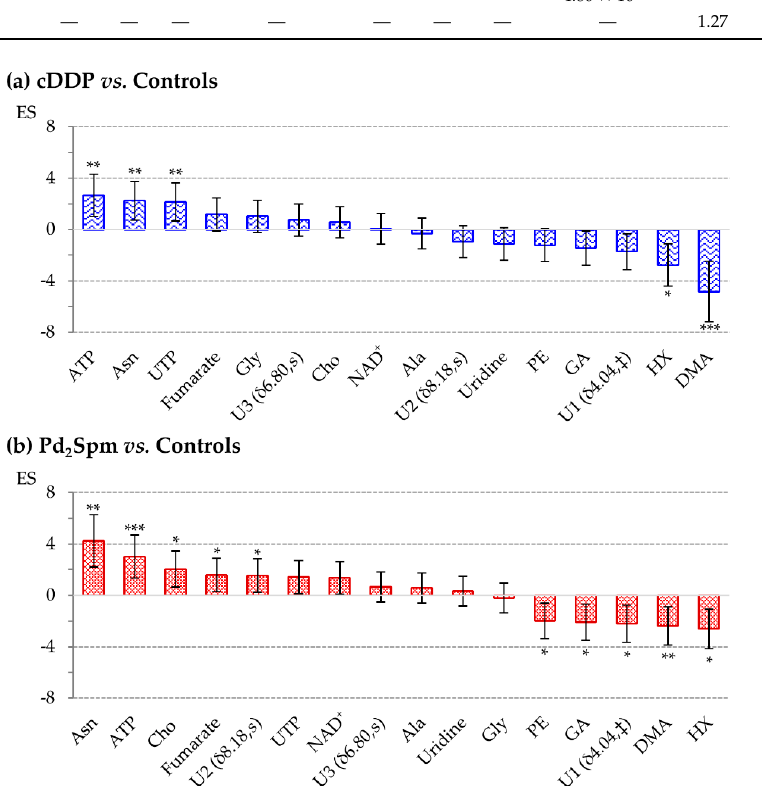
Figure 4. Bar chart illustrating effect size (ES) values [74], from maximum to minimum, for ( a ) cDDP vs . Controls and ( b ) Pd 2 Spm vs . Controls. Error bars represent the error associated to the ES calculation [74]. Asterisks represent the significance level: * p -value < 5 × 10 − 2 ; ** p -value < 1 × 10 − 2 ; *** p -value < 1 × 10 − 3 compared to controls. Abbreviations as defined in the captions of Figures 1 and 3, as well as in Table 1; ‡ Partial integration of peak.